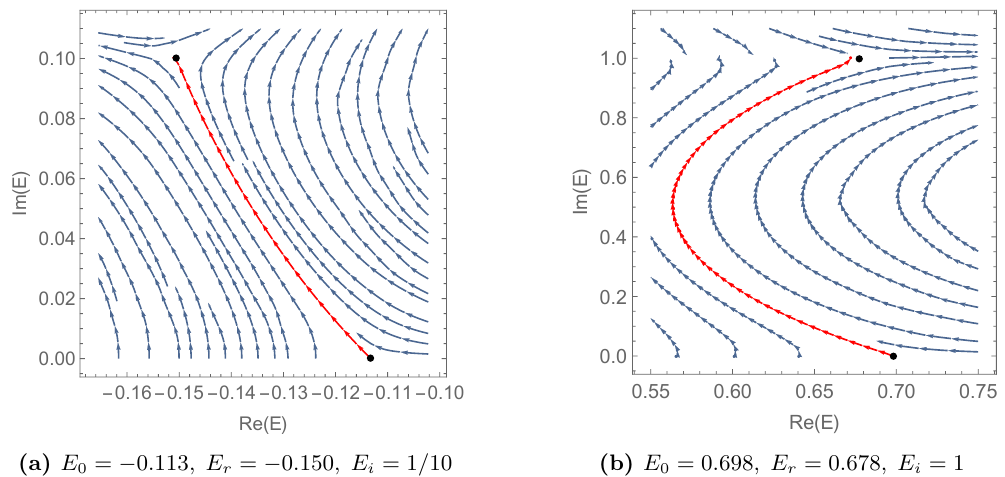
Figure 12. The stream plot of vector field ( ρ r ( E ) , − ρ i ( E )) on upper half complex E plane. The black dot on real axis is E 0 and the black dot with complex value is E + . The red curve connecting two black dots is the support of density γ + on which ρ ( E ) dE is nonnegative and real. γ − is just mirror symmetric curve with = E → −= E . In both pictures, we set 2 φ b = 1 .